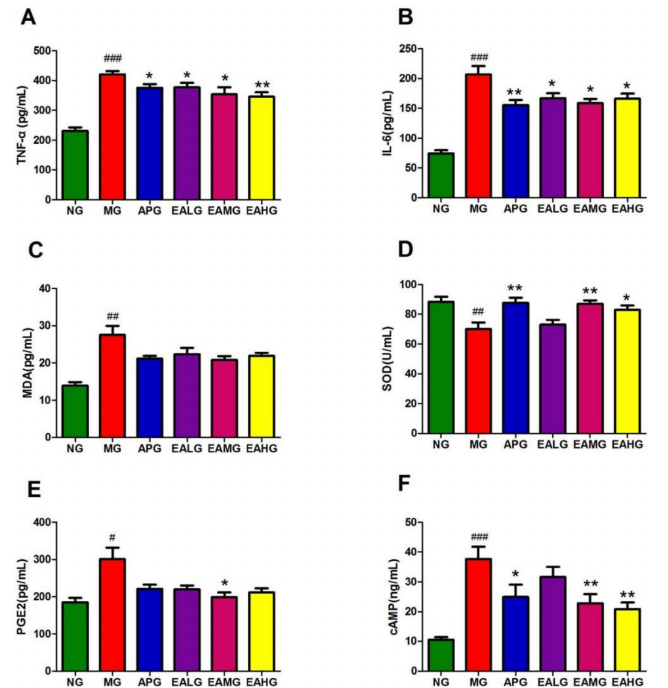
Figure 3. Anti-inflammation effects of aspirin and EA. ( A ): Effects of aspirin and EA in serum TNF- α secretion ( n = 8). ( B ): Effects of aspirin and EA in serum IL-6 secretion ( n = 8). ( C ): Effects of aspirin and EA in serum MDA secretion ( n = 8). ( D ): Effects of aspirin and EA in serum SOD activity ( n = 8). ( E ): Effects of aspirin and EA in cerebrospinal fluid PEG2 secretion ( n = 8). ( F ): Effects of aspirin